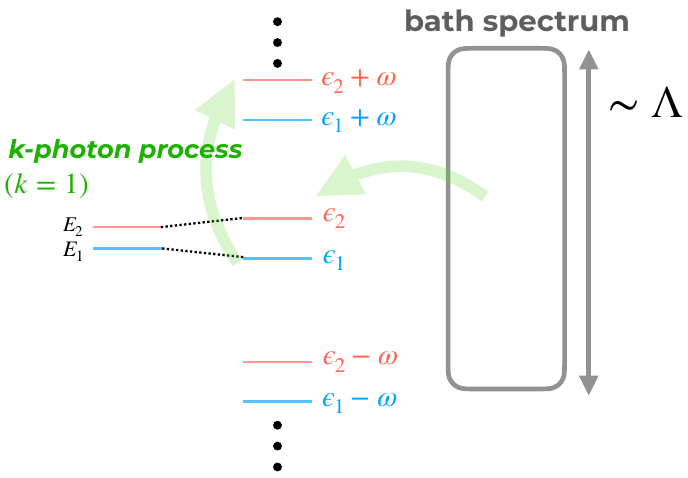
Figure 6: Schematic illustration of the k -photon process for k = 1 in a periodically driven two-level system. The curved arrow indicates a dissipation-induced transi- tion between the Floquet states m = 1 and n = 2 entailing the quasienergy change ε + ω − ε . Upon this process, the bath’s energy changes by ε 2 1 compensates the system’s quasienergy